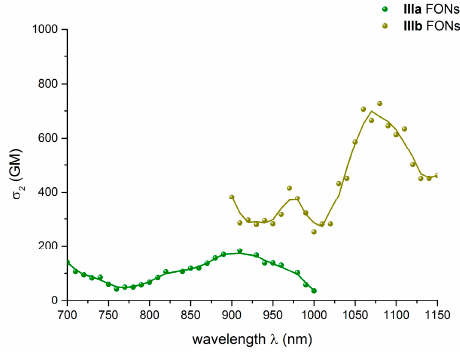
Figure 7 . Comparison of the 2PA spectra of dyes as FONs subunits for derivatives IIIa and IIIb.